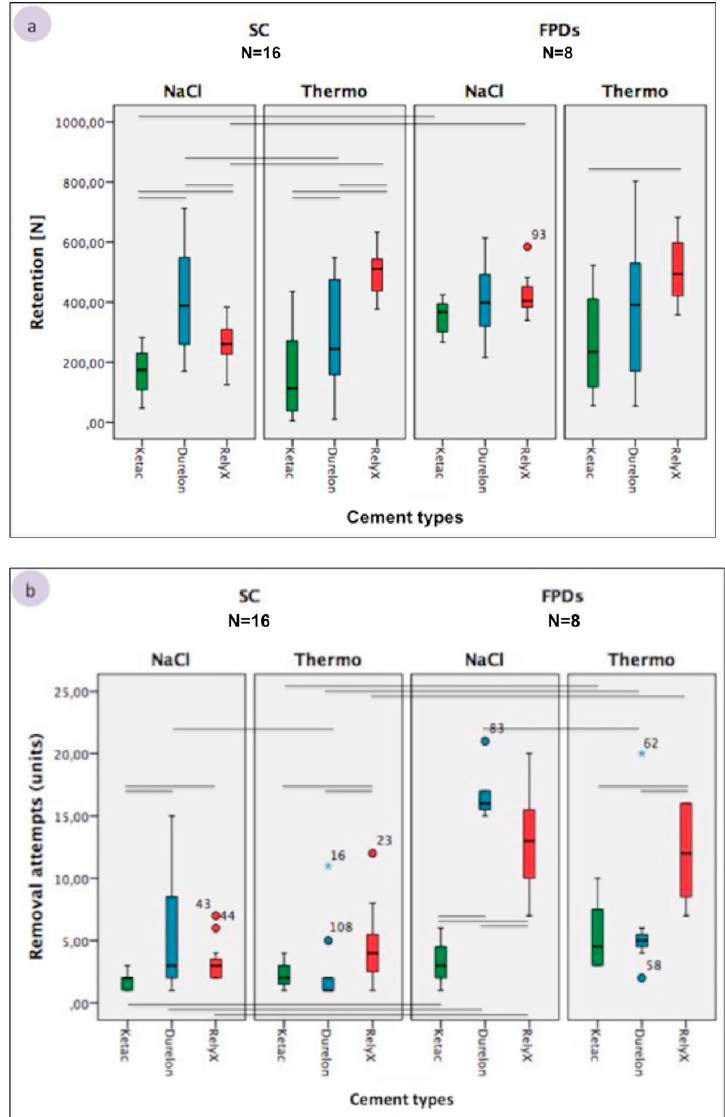
Figure 6. ( a ) Box ‐ plot graphs of the retention forces needed to remove the specimens with Zwick. All cements and both storages are illustrated. The values of all boxes are between 25% and 75% percentile. The whiskers represent the minimum and maximum value and the line inside the box shows the median. Outliers were plotted with points. Groups connected by lines are significant different ( p ≤ 0.05). ( b ) Box ‐ plot graphs of the attempt numbers needed to remove the specimens with CoronaFlex. All cements and both storages are illustrated. The values of all boxes are between 25% and 75% percentile. The whiskers represent the minimum and maximum value and the line inside the box shows the median. Outliers were plotted with points. Groups connected by lines are significant different ( p ≤ 0.05).